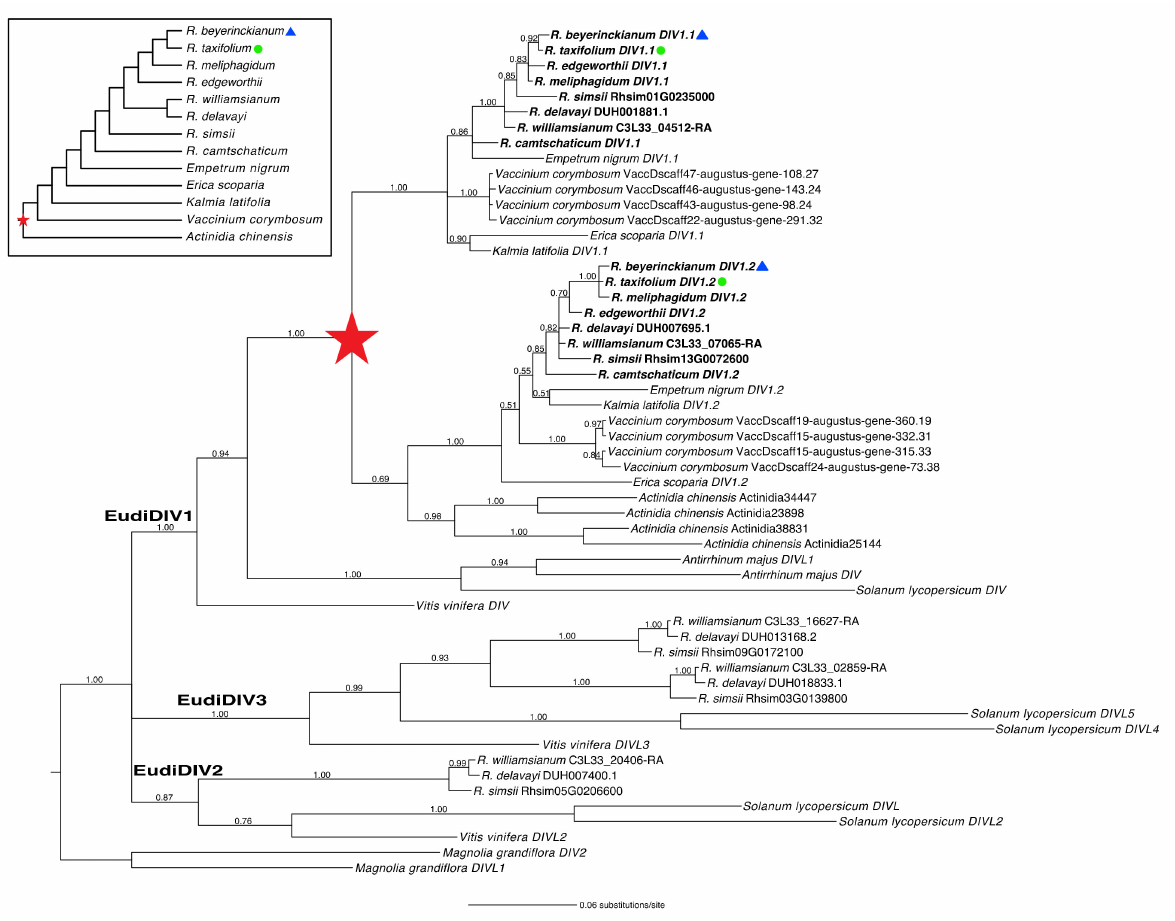
Figure 4. Evolution of DIVARICATA ( DIV ) homologs in Rhododendron (Ericaceae) and outgroups. Reconstructed Bayesian DIV phylogeny with posterior probabilities at all nodes. One gene duplication in the EudiDIV1 (DIV1) lineage, indicated by a filled red star, occurred in an ancestor of the Ericales. Experimental species are highlighted with a blue triangle (bilateral symmetry) and a green circle (radial symmetry). Inset shows sampled taxa in phylogenetic context, based on prior studies